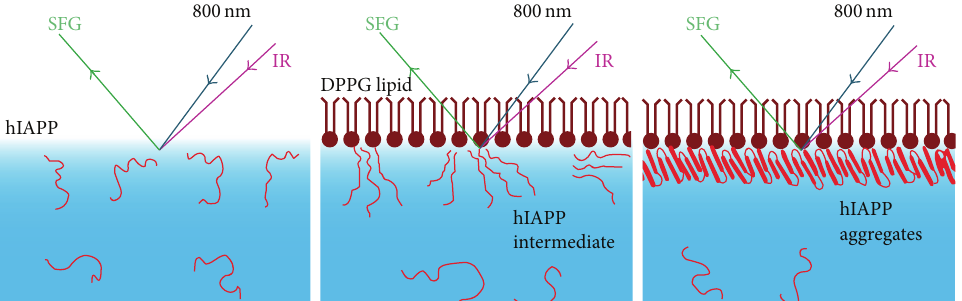
Scheme 3: Illustration of adsorption of hIAPP on a lipid monolayer and the SFG experiment for probing the hIAPP aggregations at the lipid/water interface. Adapted from [62] with permission. Copyright 2010 American Chemical